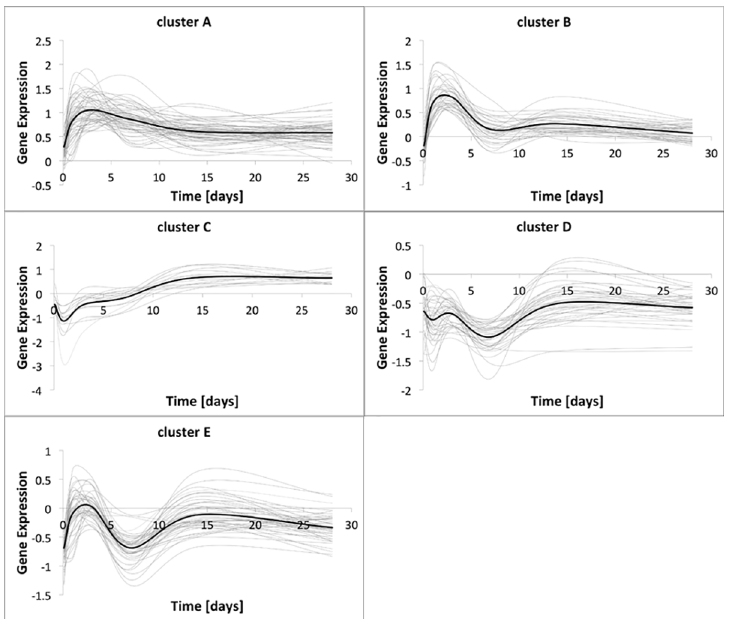
Fig 4. Genes dynamic retrievedfrom microarrayprobe for the five significant clusters. In each graph, the dynamicof each gene is representedwith a light gray solid line, whilethe cluster expression, intendedas the mean of the genesexpression, is represented with a black solid